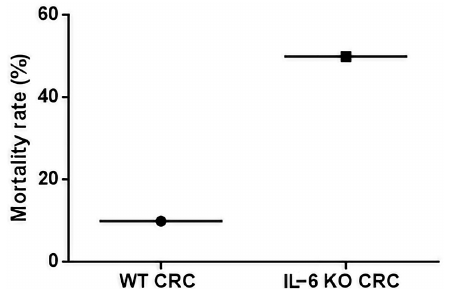
Figure 3. Mortality rate in WT CRC and IL-6 KO CRC groups (WT, IL-6 KO n = 9, respectively). Mortality rate was calculated as the number of dead animals at Week 12 divided by the total number of animals at Day 1.